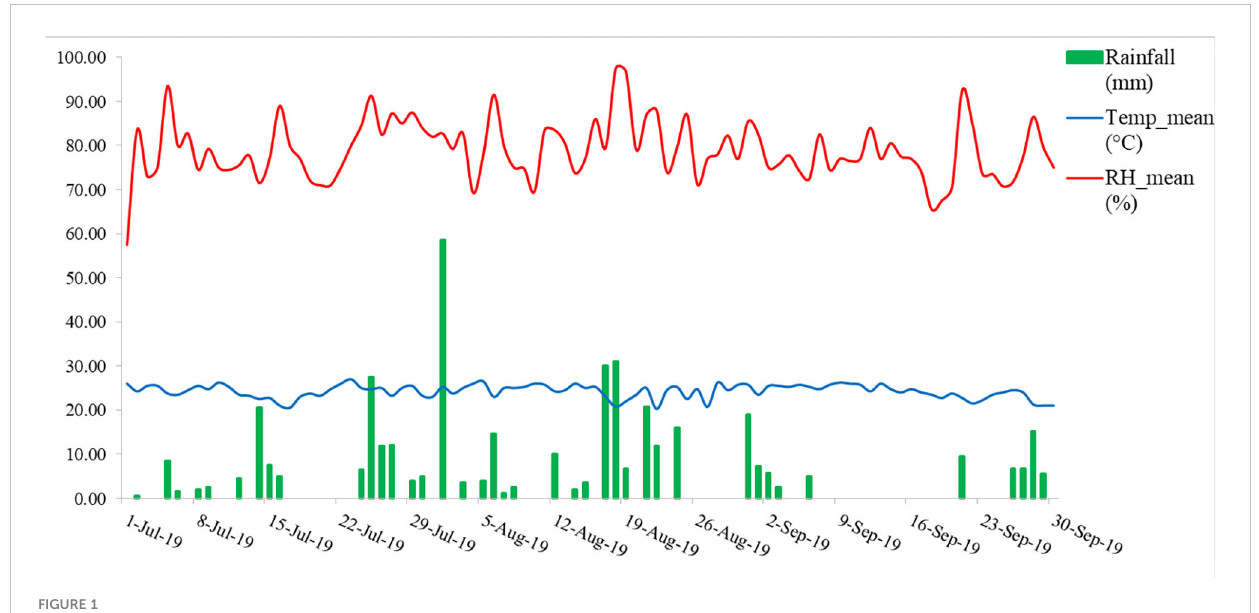
FIGURE 1 Daily weather condition during the rice growing